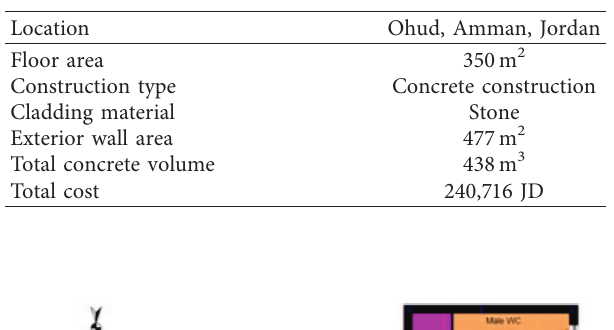
Figure 11: Ras Alain Multipurpose Hall exterior. Table 1: Basic data of Ras Alain Multipurpose Hall.